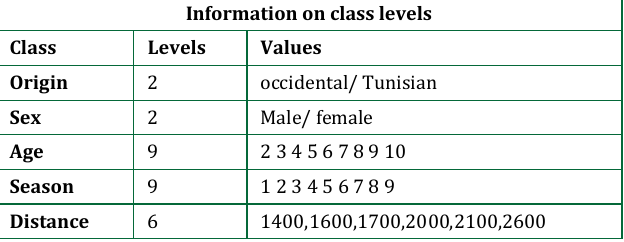
Table 1: Descriptive statistics for the horses used in the study